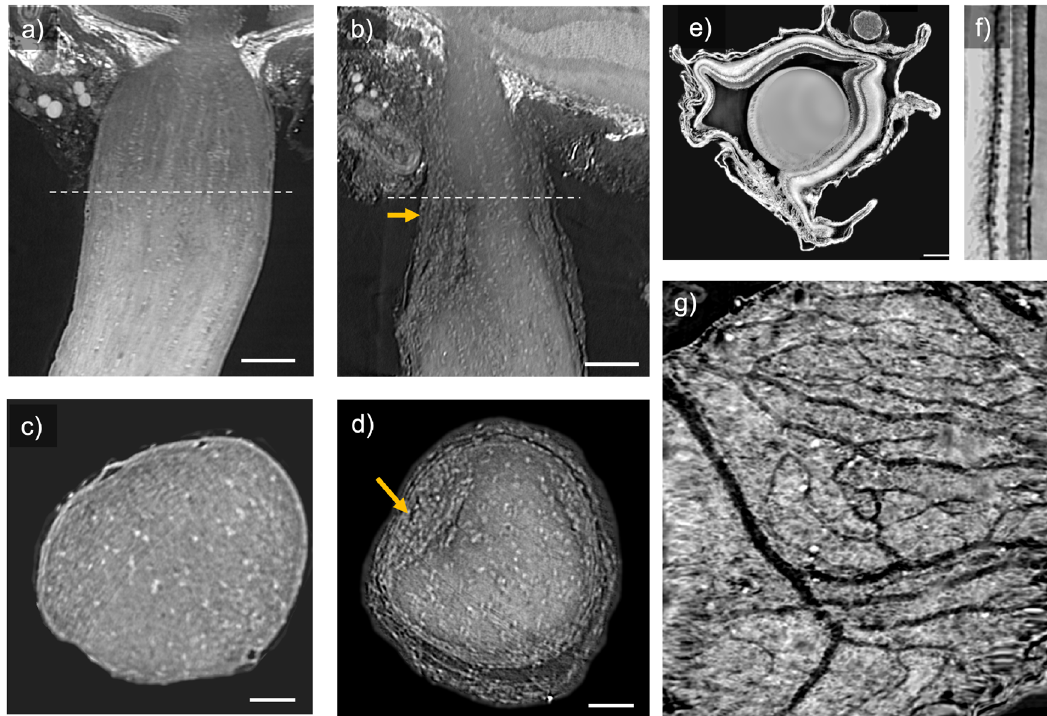
Fig. 6 Pathological alterations in optic nerve. X-ray phase contrast tomography (XPCT) shows pathological alterations in experimental autoimmune encephalomyelitis (EAE) optic nerve and allows the visualization of ocular vascularization. a – d XPCT images showing the longitudinal ( a , b ) and axial ( c , d ) views of the optic nerve in a naive mouse ( a , c ), and an EAE-induced mouse at disease onset ( b , d ), where large accumulations of in fl ammatory cell in fi ltrates (arrows) compatible with the occurrence of optical neuritis are visible. The dashed lines in ( a , b ) illustrate the location of the axial sections ( c , d ). Scale bar ( a , b ) = 100 μ m. Scale bar ( c , d ) = 50 μ m. e XPCT image showing a section of ocular bulb from a naive mouse. Structural deformations due to sample preparation in paraf fi n are visible. Scale bar = 200 μ m. f , g Representative results of virtual fl attening of a naive mouse eye: lateral section of retina ( f ) and the en face surface of the highly vascularized choroidal layer ( g ). Samples presented in a – d and g were embedded in epon, whereas samples presented in e and f were embedded in paraf fi n. Clinical EAE score at the onset = 2.5. XPCT images were acquired in Experiment 4, reported in